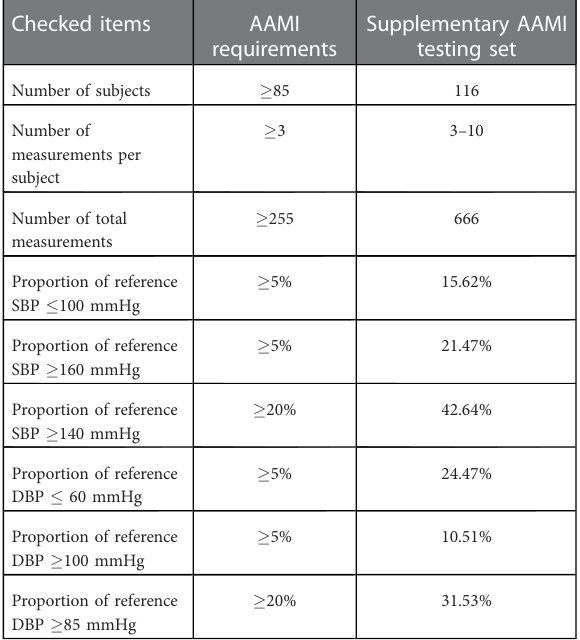
TABLE 7 AAMI standard requirements and their corresponding values for the supplementary AAMI testing set generated from subjects retrieved from only VitalDB. This is a subset of the AAMI testing set summarized in Tables 2 and